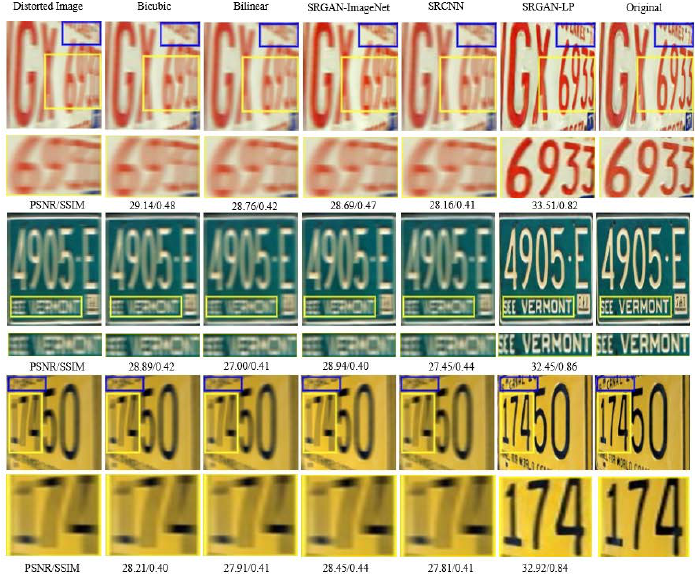
Figure 5. Visual quality along with corresponding PSNR/SSIM of the reconstructed images using